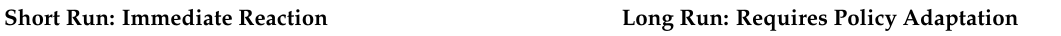
Table 3. Clustered BSCh features that could contribute to the post-COVID-19